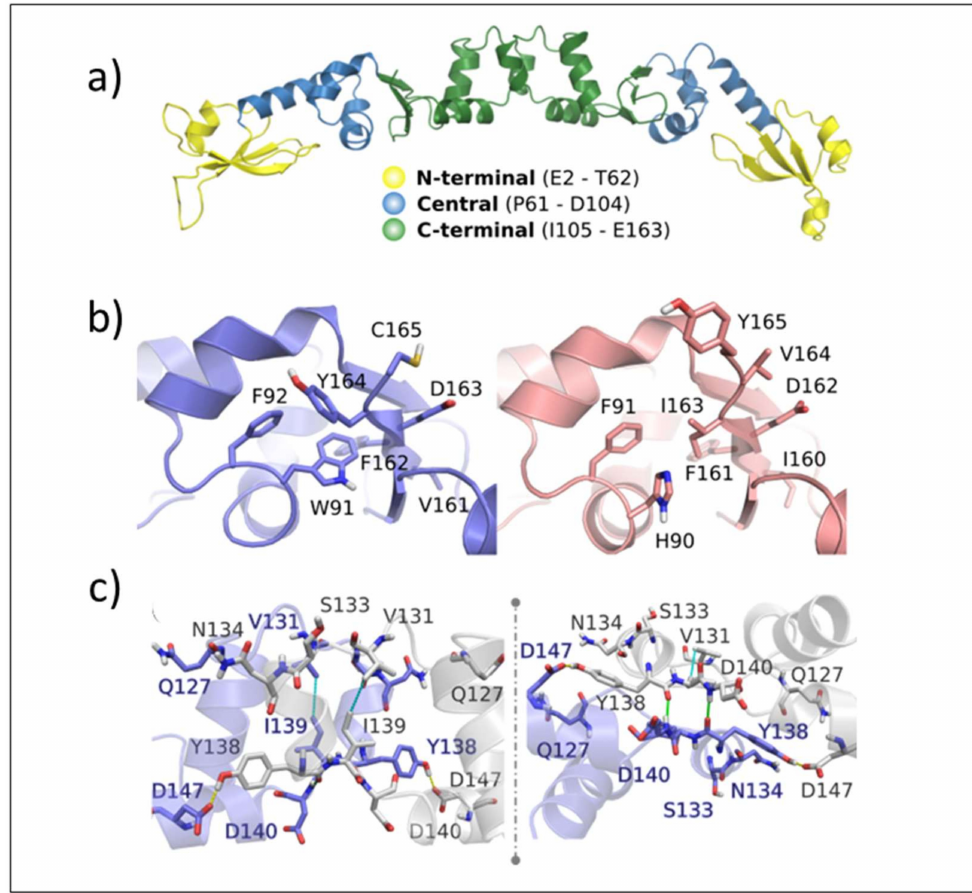
Figure 9. ( a ) ArdA-H1 domains: N-terminal (yellow), central (blue), and C-terminal (green). ( b ) Essential residues and the VF-motif (V161 and F162) of ArdA-H1 (left, purple) and ArdA-H2 (right, salmon). ( c ) The ArdA-H1 anti-restriction domain with the main amino acids represented as sticks and rotated 45 ◦ (right). Chain A (purple) and chain B (grey). Hydrogen bonds between side chains and main chains are highlighted in yellow dashed and green solid lines, respectively. Nonpolar interactions are highlighted in cyan dashed